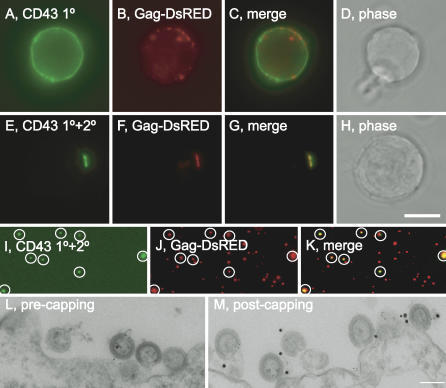
Higher-Order Oligomerization Targets CD43 to HIV VLPs(A–H) Jurkat T cells expressing HIV Gag-DsRed were labeled with FITC-conjugated mouse anti-CD43 antibodies and either (A–D) buffer or (E–H) polyclonal rabbit anti-mouse IgG antibodies, grown for 24 h at 37 °C, and examined by fluorescence microscopy of. Bar indicates 10 μm.(I–K) Fluorescence microscopy of exosomes secreted by cells expressing HIV Gag-DsRED and incubated with FITC-primary and secondary antibodies to CD43. White circles mark exosomes that contain both CD43-antibody complexes and HIV Gag-DsRED.(L and M) Immunoelectron microscopy of N-Rh-PE–labeled Jurkat T cells expressing untagged, full-length HIV Gag, incubated with primary and secondary antibodies to CD43 and then either (L) fixed or (M) incubated at 37 °C for 2 h and then fixed. Samples were then incubated with immunogold to detect (6 nm) N-Rh-PE and (18 nm) CD43. Bar indicates 100 nm.